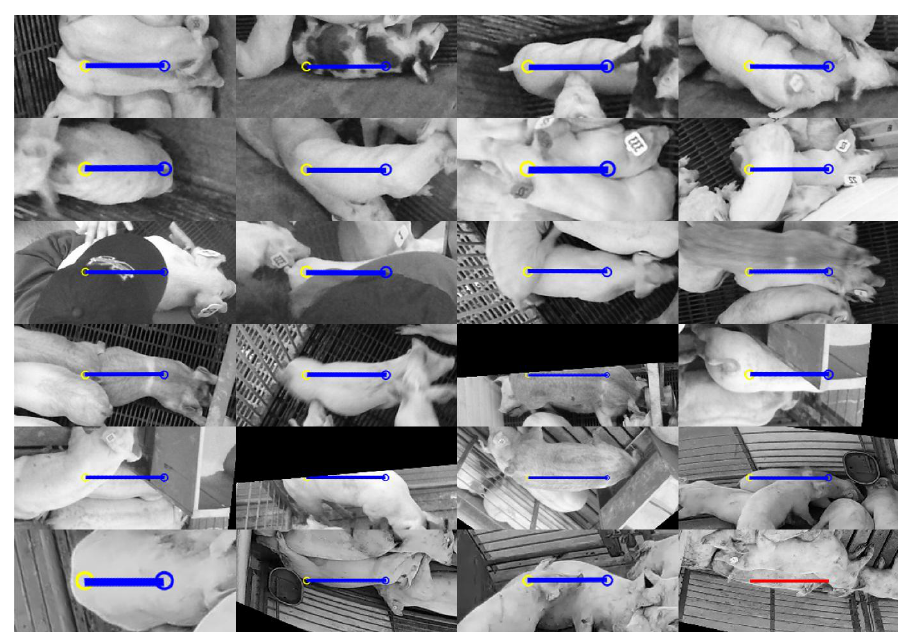
Figure 13. Twenty-four random samples of unsuccessful instance detections from the test:seen set using the following color coding: false negative (blue), and false positive (red).